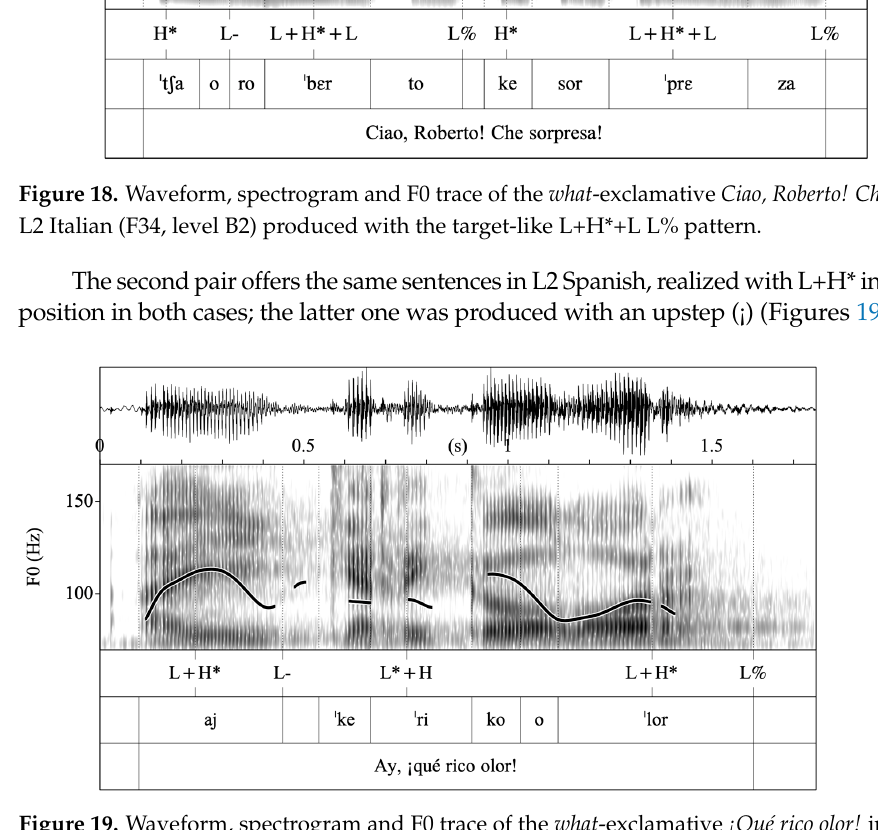
Figure 19. Waveform, spectrogram and F0 trace of the what -exclamative ¡Qué rico olor! in L2 Spanish (M17, level C1) produced with the target-like L+H* L% pattern.